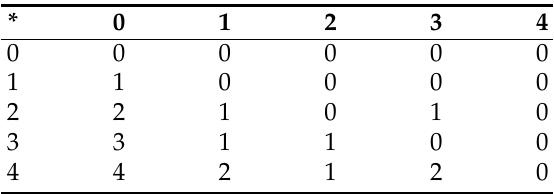
Table 9. Cayley table for the binary operation “ ∗ ”.